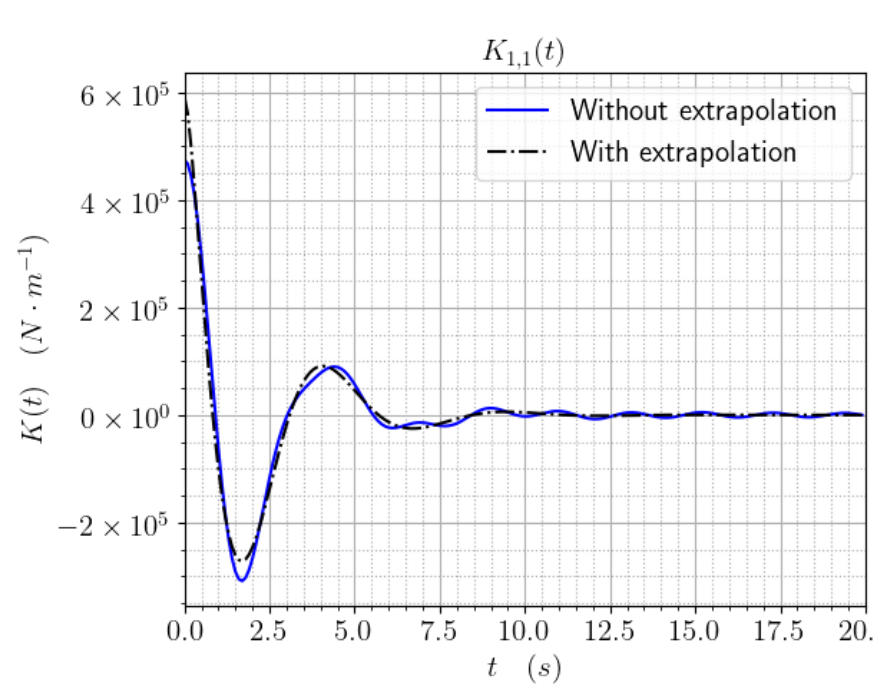
Figure 3. Kernel function K jk with and without extrapolation with j = k =